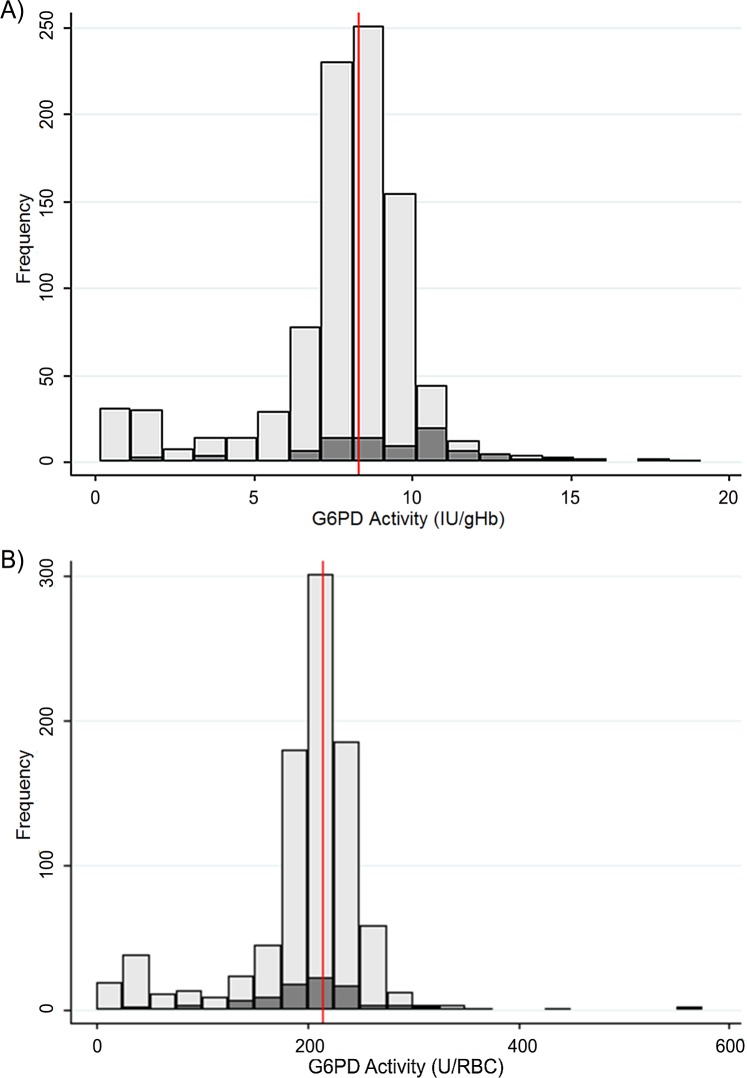
Distribution of G6PD activity in women with or without anemia shown as histograms for G6PD activity normalized for (A) hemoglobin concentration and (B) red blood cell count (RBC). Vertical reference line is the population median.